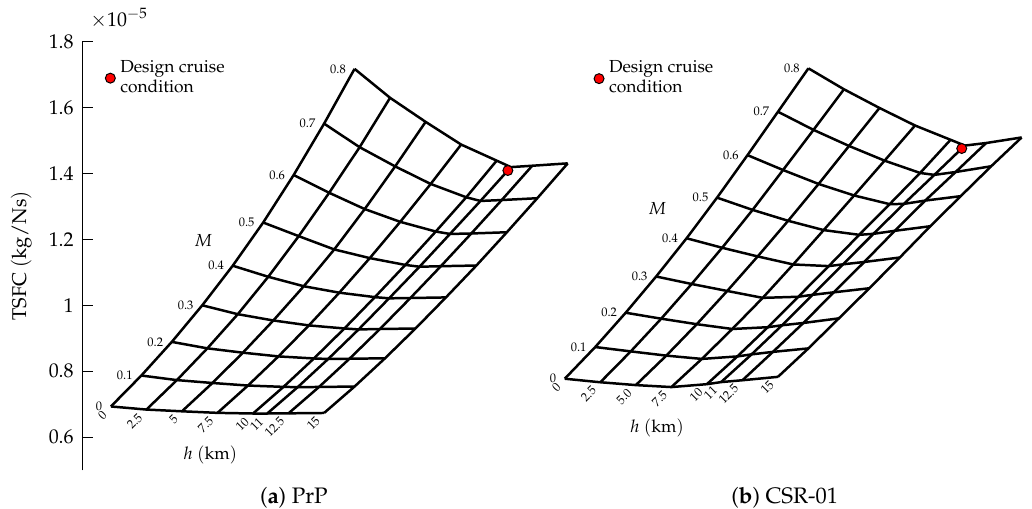
Figure 4. Thrust specific fuel consumption carpet plots at max thrust for the ( a ) PrP and ( b )